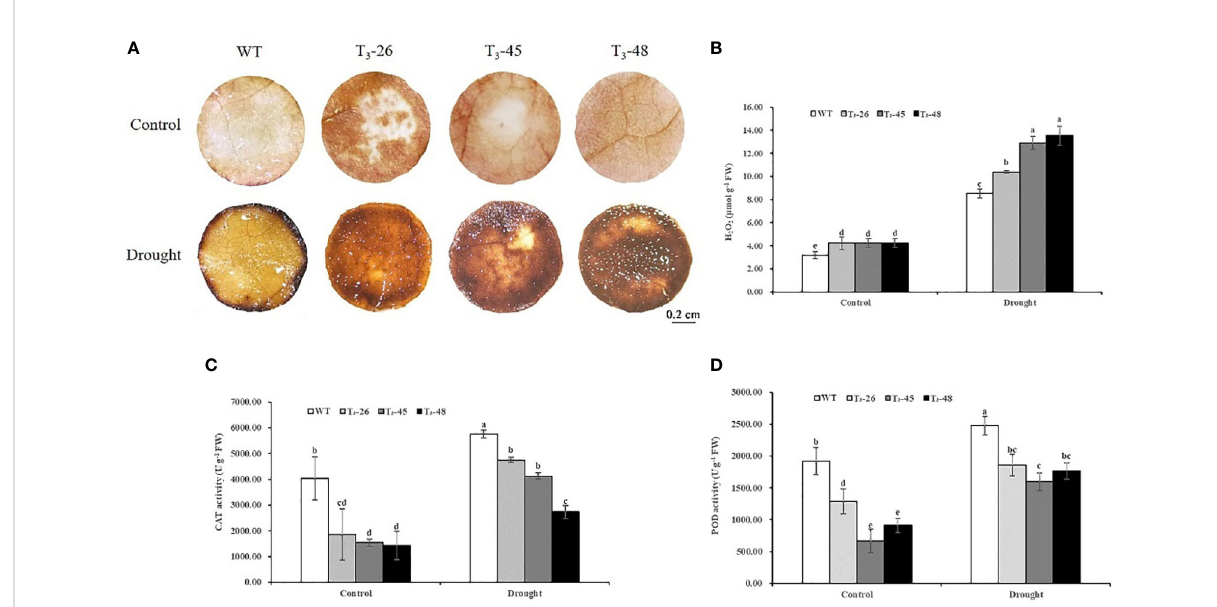
FIGURE 7 NtCPS2 functions in antioxidant capacity. After 6 h of drought treatment, WT and transgenic plants were stained with DAB (A) and subjected for H 2 O 2 content determination (B) . The activity levels of antioxidant enzymes CAT (C) , POD (D) in three transgenic plants and WT plants were treated with drought for 6 h. Scale bar =0.2 cm. Error bars represent means ± SD. Statistical analysis was performed using the ANOVA test (p< 0.05) and signi fi cant differences are indicated by different